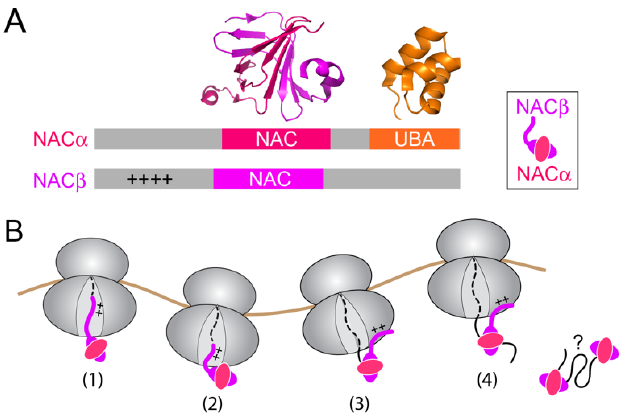
Figure 4. Proposed structure and interactions of NAC. ( A ) Overview of the domain composition and available structural information of NAC. Grey depicts unstructured extensions from the folded NAC and UBA domains. ‘++++’ denotes the basic RRKKK motif in the N-terminal extension of NAC β crucial for its ribosome binding. The crystal structures are shown for the C-terminal UBA domain of NAC α (PDB: 1TR8) as well as the α / β NAC domain, which dimerizes into a β -barrel like structure (PDB: 3MCB). ( B ) Summary of models of NAC interaction with ribosome and the nascent chain during protein synthesis. NAC engages ribosome early during translation, with the N-terminal tail of NAC β inserting deeply into the exit tunnel of the ribosome (stage (1)). The inserted N-terminal tail of NAC β begins to retract in the tunnel as the nascent chain elongates to ~30 amino acids (stage (2)), and switches to interact with the ribosome surface upon the emergence of the nascent protein from the exit tunnel (stage (3)). NAC is likely anchored by the N-terminal NAC β tail on the ribosome, and the central NAC β -barrel could continue to contact portions of the nascent protein that just emerge from the tunnel exit as the nascent chain further elongates (stage (4)). Finally, NAC could also associate with aggregation prone proteins when released from the ribosome, although the molecular mechanism of NAC interactions off the ribosome awaits further investigation (?). ‘++++’ denotes the basic RRKKK motif at the N-terminus of NAC β